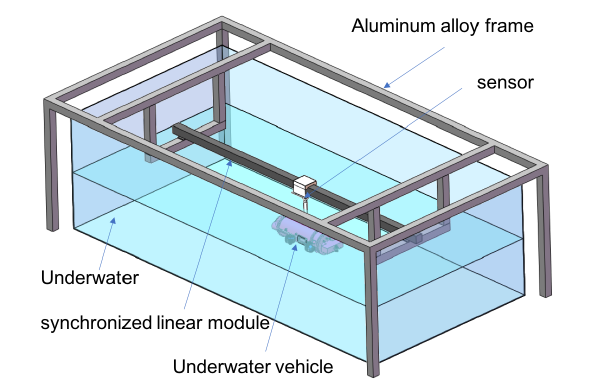
Figure 18. Introduction of the physical experiment